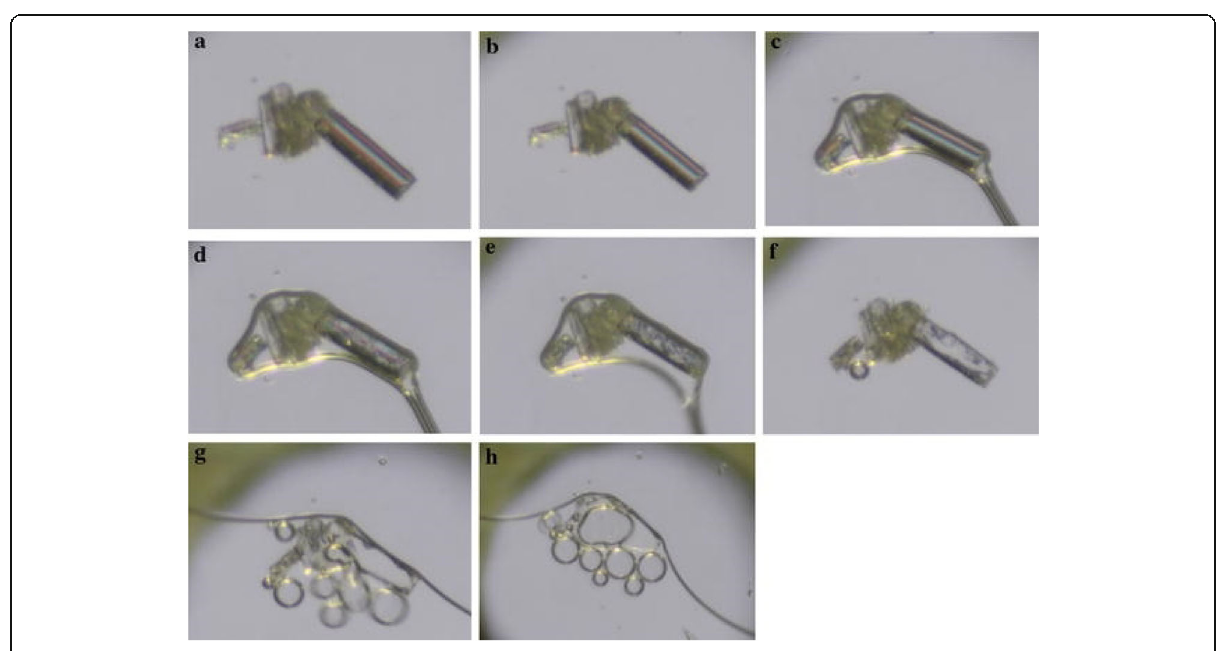
Fig. 8 p-coumaric acid and quinine solvate at different temperatures. a 24.85 °C, b 73.85 °C, c 99.85 °C, d 152.85 °C, e 155.85 °C, f 159.85 °C, g